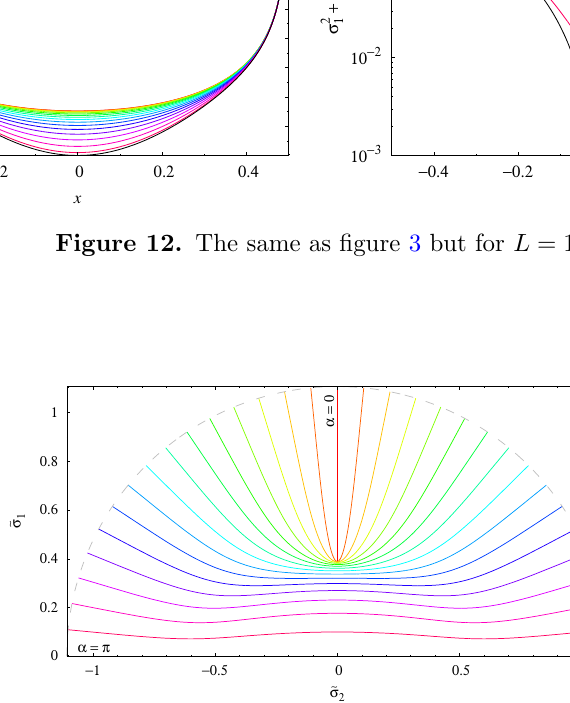
Figure 13. The same as (cid:12)gure 5 but for L = 1.